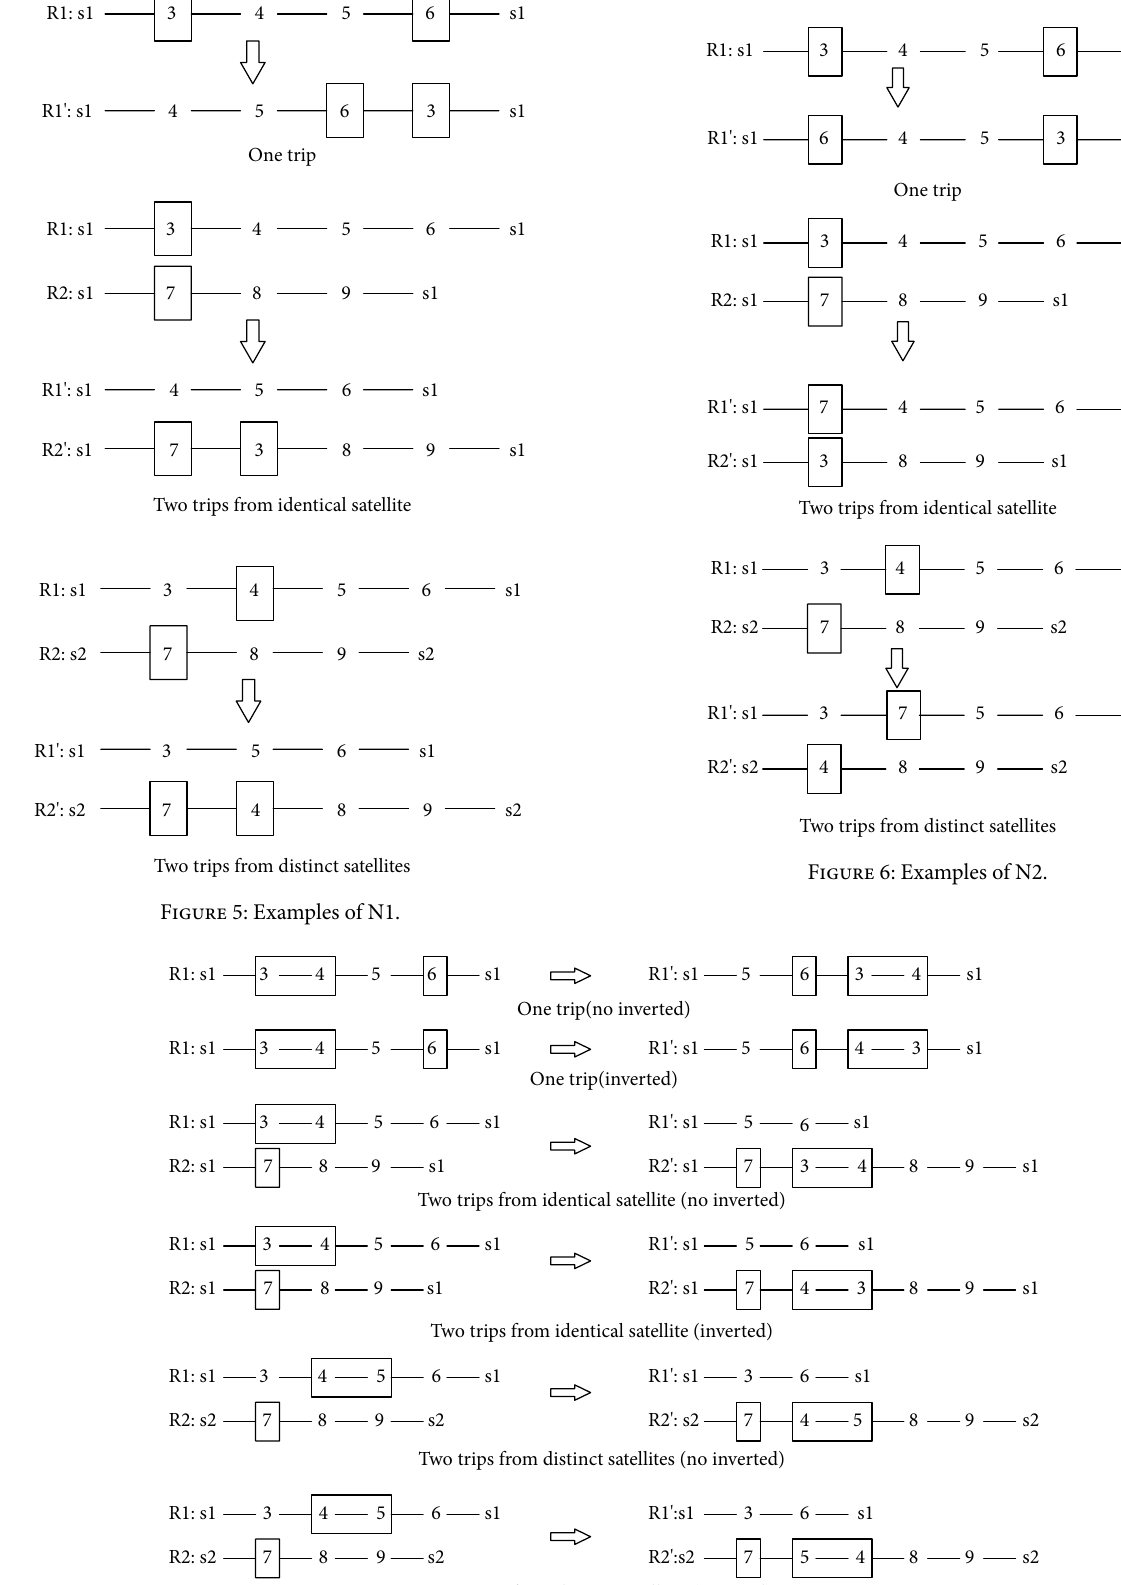
Figure 7: Examples of